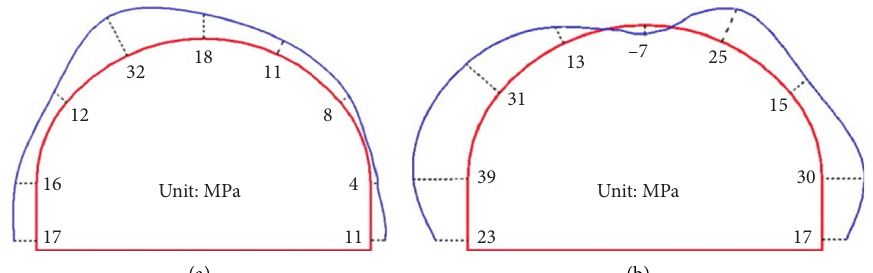
Figure 13: Stress distribution of secondary lining steel bar at YK2+449 section. (a) Maximum stress of outer side steel bar i (b) Maximum stress of inner side steel bar.